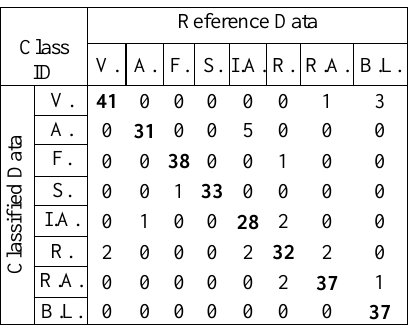
Table 3. The error matrix of the classification result that was obtained by using Landsat-9 satellite image (V: Vegetation, A: Airport, F: Forest, S: Sea, I.A.: Industrial Area, R: Road, R. A.: Residential Area, B. L.: Barren Land).